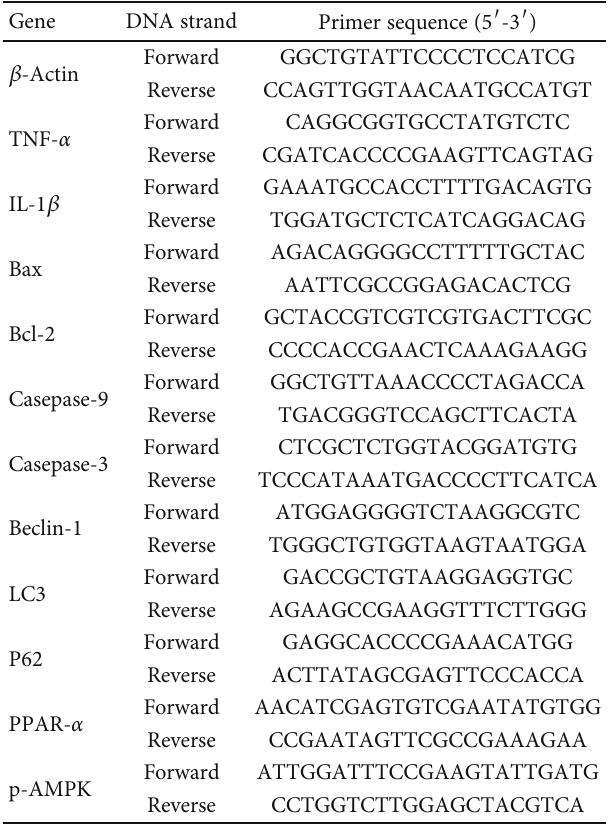
Table 1: Oligonucleotide sequences of primers used for qRT-PCR. Gene DNA strand Primer sequence (5 ′ -3 ′